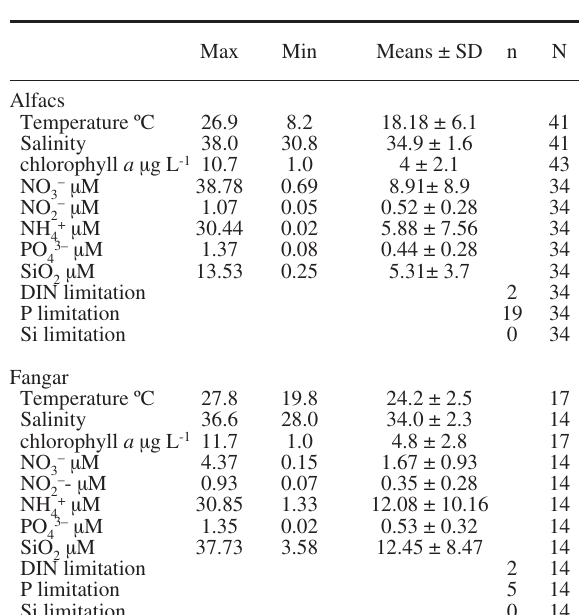
Table 2. – Maximum, minimum and mean values for chemical and biological parameters measured at the surface and the bottom of each bay. the measurement period in each bay corresponded to the bloom period (cell abundance of Pseudo-nitzschia >10 5 cells l -1 ). which extended from august 29 2005 to February 20 2006 in alfacs Bays and from august 8 to october 2005 in Fangar Bay. probable inorganic dissolved nutrient limitations (din, p, and Si) are indi- cated (n= case number of limitation). n is the total number of the